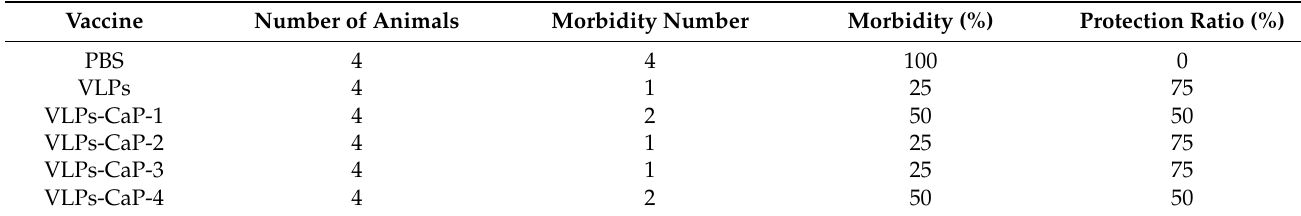
Table 2. Protection of guinea pigs after challenge with FMDV.